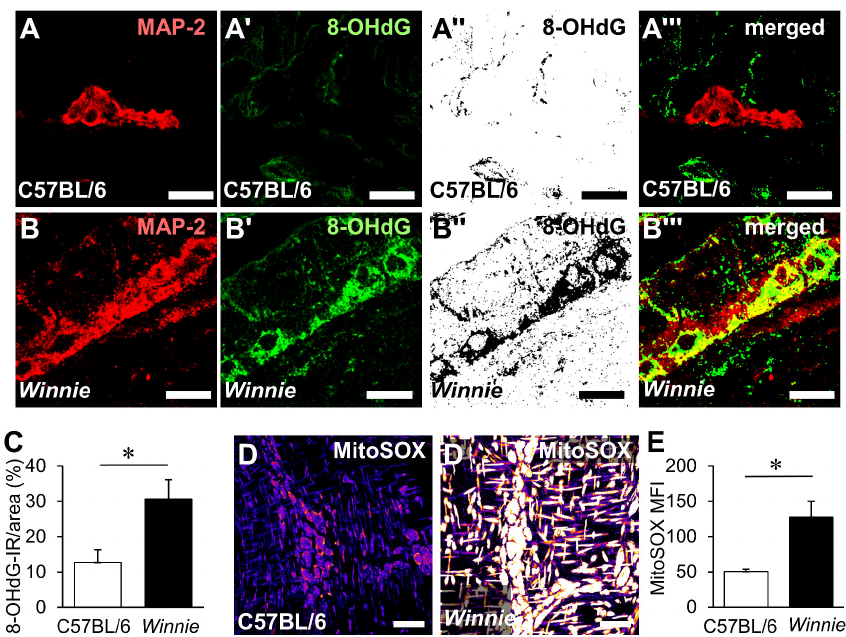
Figure 3. Oxidative stress in the myenteric ganglia of Winnie mice. ( A – B’’’ ) DNA/RNA oxidative damage in neurons within the myenteric ganglia was visualised by immunofluorescence using the neuronal marker MAP-2 ( A , B ) and the DNA/RNA damage marker 8-OHdG ( A’ , B’ ). Adducts of 8-OHdG were observed in binary images of 8-OHdG immunofluorescence ( A’’ , B’’ ). Co-localisation of 8-OHdG adducts with MAP-2 was viewed in merged images in cross sections from the distal colon of C57BL/6 mice ( A – A’’’ ) and Winnie mice ( B – B’’’ ) (scale bar = 20 µm). ( C ) Quantification of 8-OHdG adducts as a percent of the area in the myenteric neurons in colonic cross sections. * p < 0.05; C57BL/6: n = 6 animals, Winnie : n = 7 animals. ( D , D’ ) Mitochondria-derived superoxide (O 2− ) in the myenteric ganglia was visualised by the fluorescent probe MitoSOX in LMMP wholemount preparations from the distal colon of C57BL/6 mice ( D ) and Winnie mice ( D’ ) (scale bar = 50 µm). All images were taken using the same acquisition settings and are pseudo-coloured (LUT: ‘ heat’, ImageJ) for greater visual distinction in this figure. ( E ) The mean fluorescence intensity of the myenteric ganglia in single-channel 16-bit images was quantified to determine the intensity of MitoSOX fluorescence. * p < 0.05; C57BL/6: n = 5 animals, Winnie n = 6 animals. Comparable results were observed in organotypic cultures exposed to H 2 O 2 . Appli- cation of H 2 O 2 (n = 9 independent cultures) decreased the total number of neurons with nuclear HMGB1 expression (Figure 5B–B’’’’) and increased the total number of neurons with cytoplasmic HMGB1 translocation (Figure 5C–C’’’’) compared to controls ( p < 0.05, for both) (Figure 5D,D’, Table S2). A negative correlation was observed between the num- ber of neurons with cytoplasmic HMBG1 and neuronal density (F(1,13) = 38.12, p < 0.0001, R 2 = 0.7457) (Figure 5E, Supplementary Table S4). Similarly, the proportion of neurons with HMGB1 expression in the nucleus decreased ( p < 0.05) and the proportion of neurons without nuclear HMGB1 ( p < 0.05) or those with cytoplasmic HMBG1 ( p < 0.05) increased (Figure 5F–F’’, Table S2). The proportion of neurons with HMGB1 translocation was neg- atively correlated to neuronal density (F(1,13) = 26.21, p < 0.001) with an R 2 of 0.6685 (Fig- ure 5G, Table S4). Similar to organotypic cultures under hyperoxia, no difference was ob- served in the number of non-neuronal cells with nuclear or translocated HMGB1 in the myenteric ganglia after treatment with H 2 O 2 (Figure 5H,H’, Table S2). Together, these data demonstrate that HMGB1 translocation is regulated by oxidative stress in myenteric neu- rons and highlights the relationship between HMGB1 and neuronal loss under oxidative conditions.